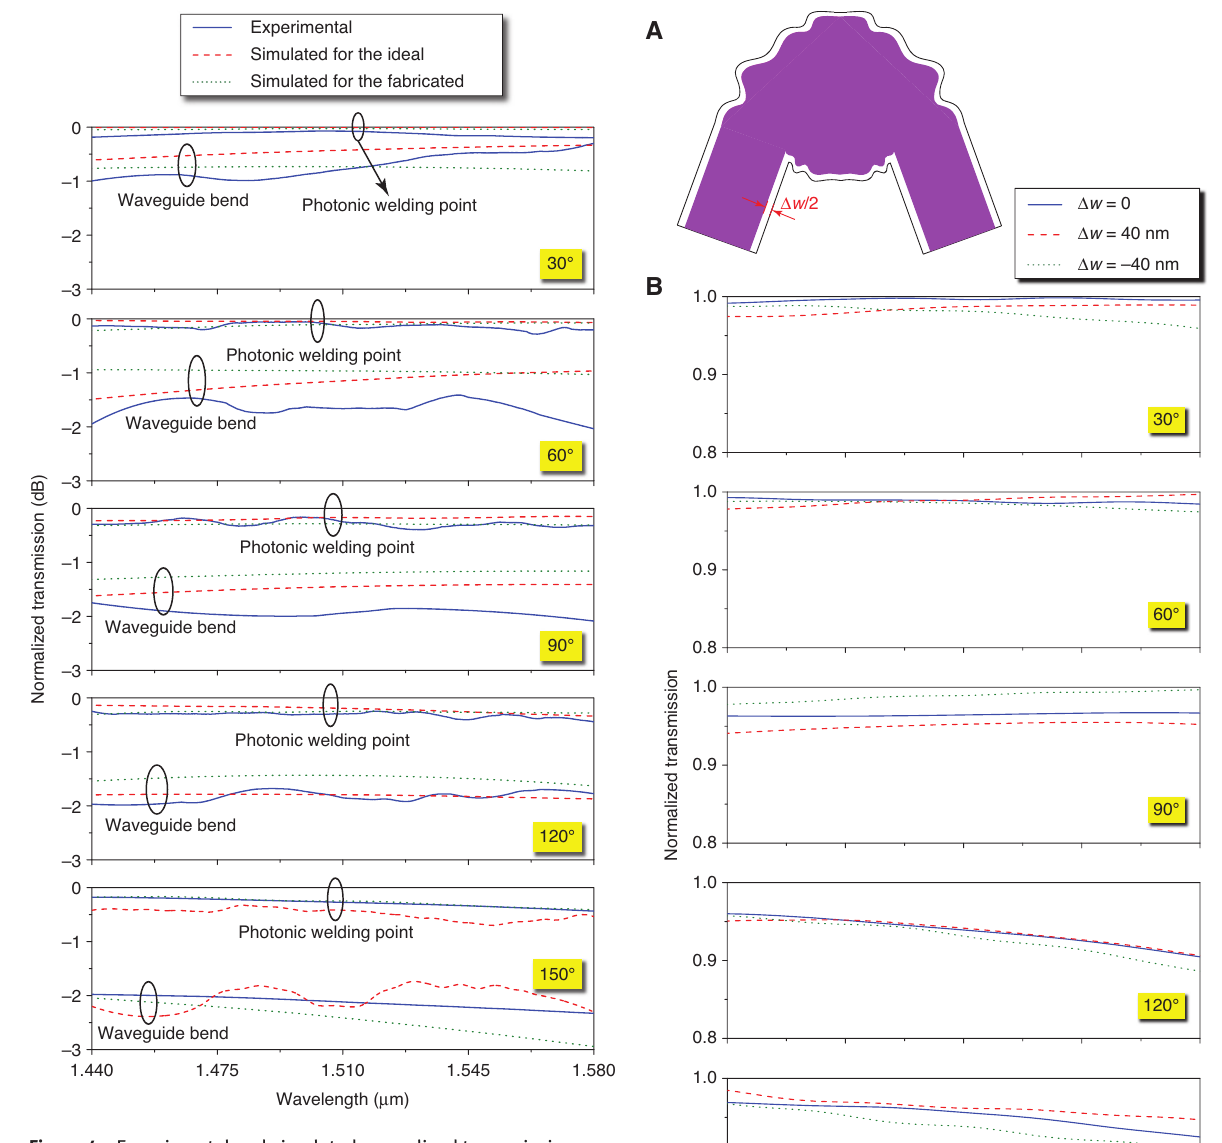
Figure 4: Experimental and simulated normalized transmission spectra of single photonic welding point and waveguide bend for connecting two waveguides with bending angles of 30 ° , 60 ° , 90 ° , 120 ° , and 150 ° . Blue solid lines represent the experimentally measured results, red dashed lines represent the simulated results for the ideal structure, and green dotted lines represent the simulated results for the fabricated